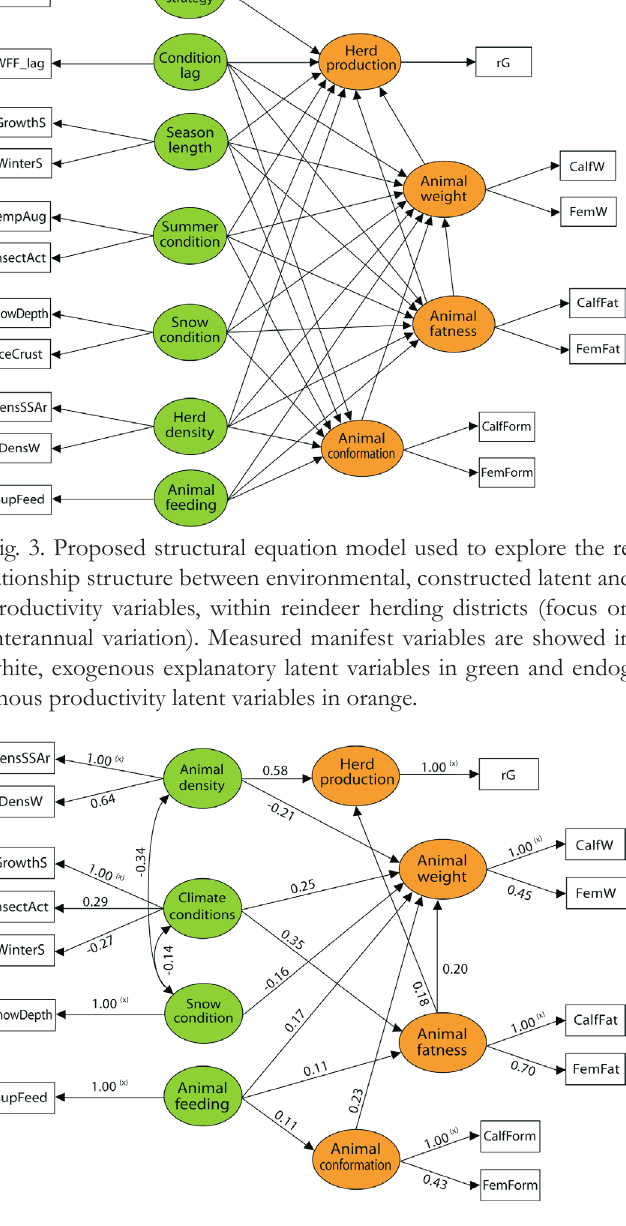
Fig. 4. Estimated parameters of the final structural equation model describing interannual variation within herding districts. Significant ( P ≤ 0.10) path coefficients and latent variable covariances between manifest variables (white), exogenous latent variables (green), and endogenous latent variables (orange) are shown as solid arrows. Fixed correlations are marked with (x) and correlation between exog- enous latent variables are drawn in